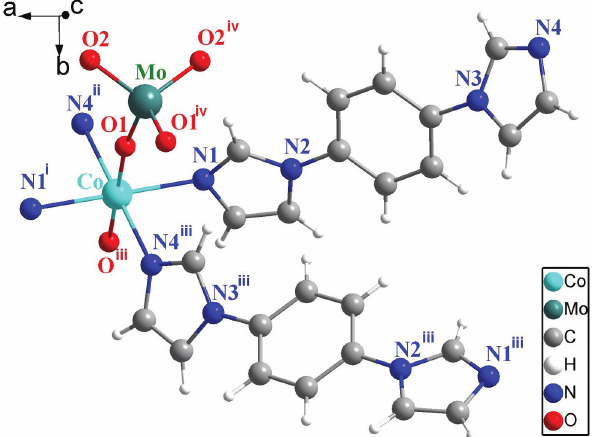
Table 2: Fractional atomic coordinates and isotropic or equivalent isotropic displacement parameters (Å 2